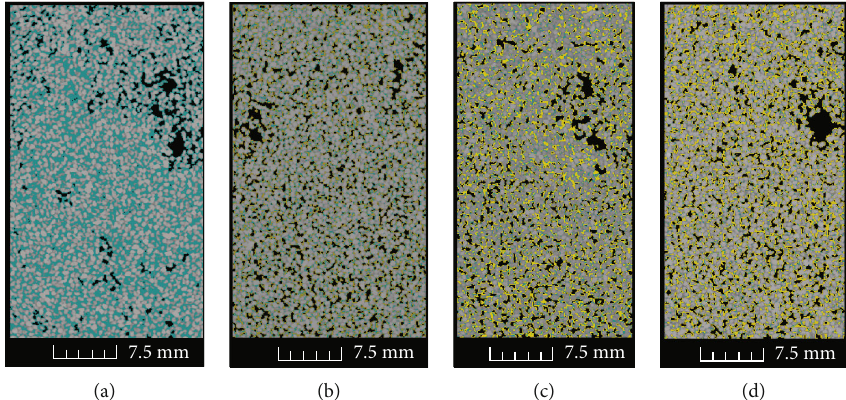
Figure 4: Micro-distribution of gas hydrate during hydrate formation process under methane fl ux conditions. (a) Hydrate saturation =0%, (b) Hydrate saturation =22.13%, (c) Hydrate saturation =47.33%, (d) Hydrate saturation =59.87%. The yellow is methane hydrate. The blue is NaCl solution. The light gray is sands. The black is methane gas.